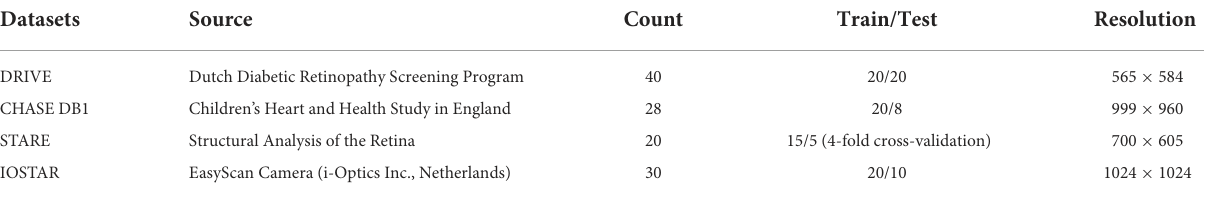
TABLE 1 The detail information of four